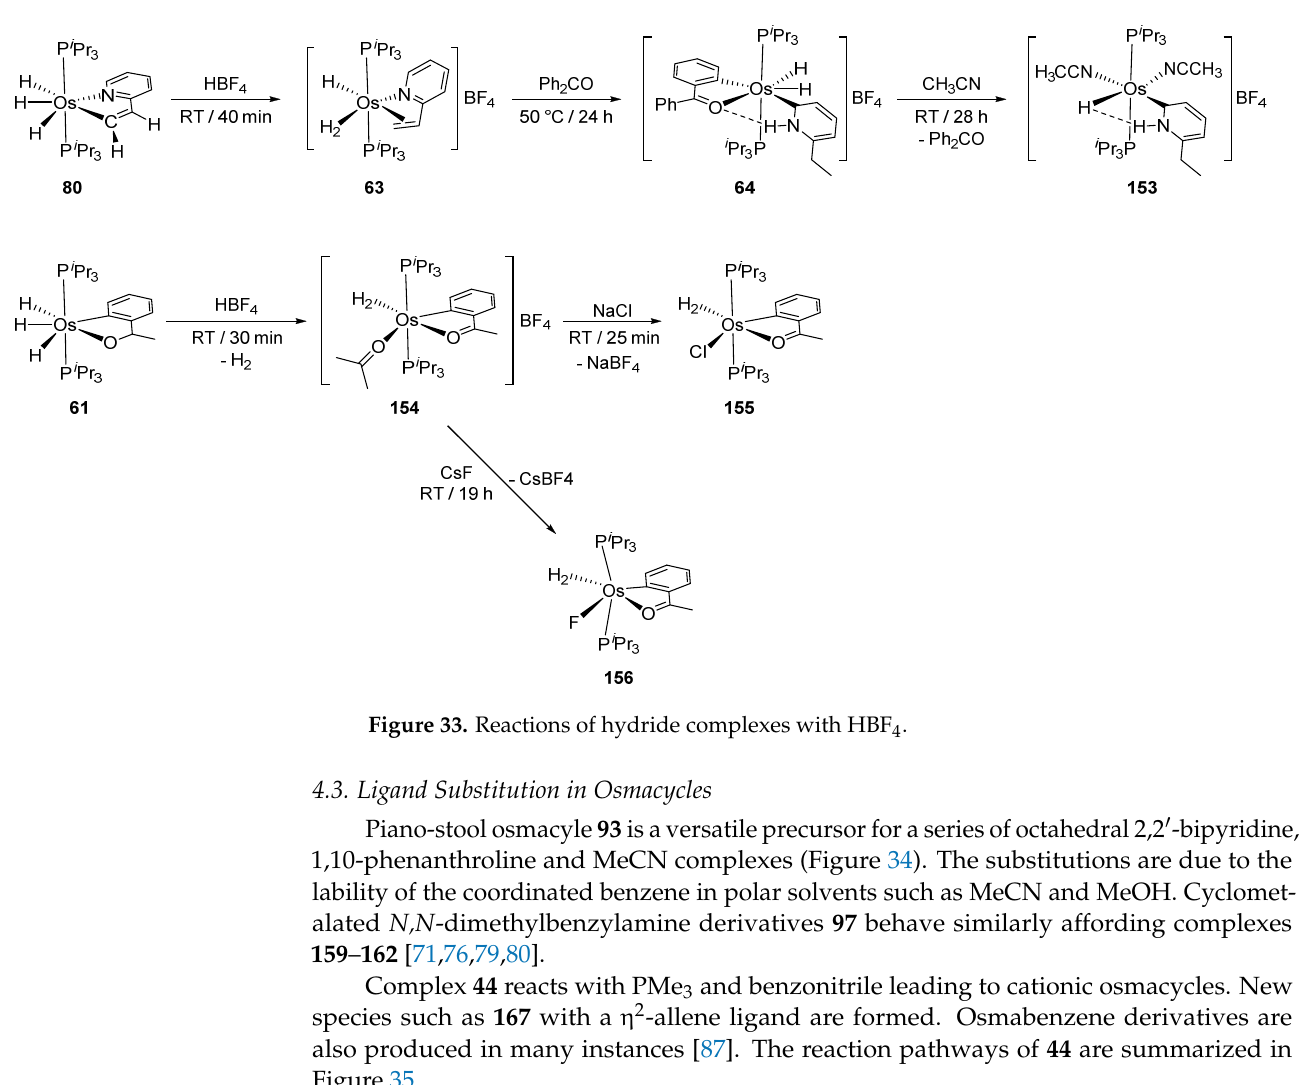
Figure 34. Synthetic routes to octahedral cyclometalated derivatives by ligand substitution starting from piano-stool complex 93 .